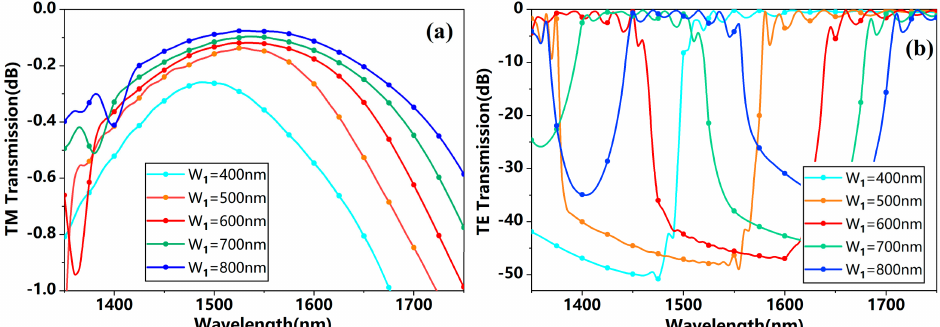
Figure 4. The wavelength dependent transmittances evaluated with various waveguide widths W 1 for ( a ) TM polarization state and ( b ) TE polarization